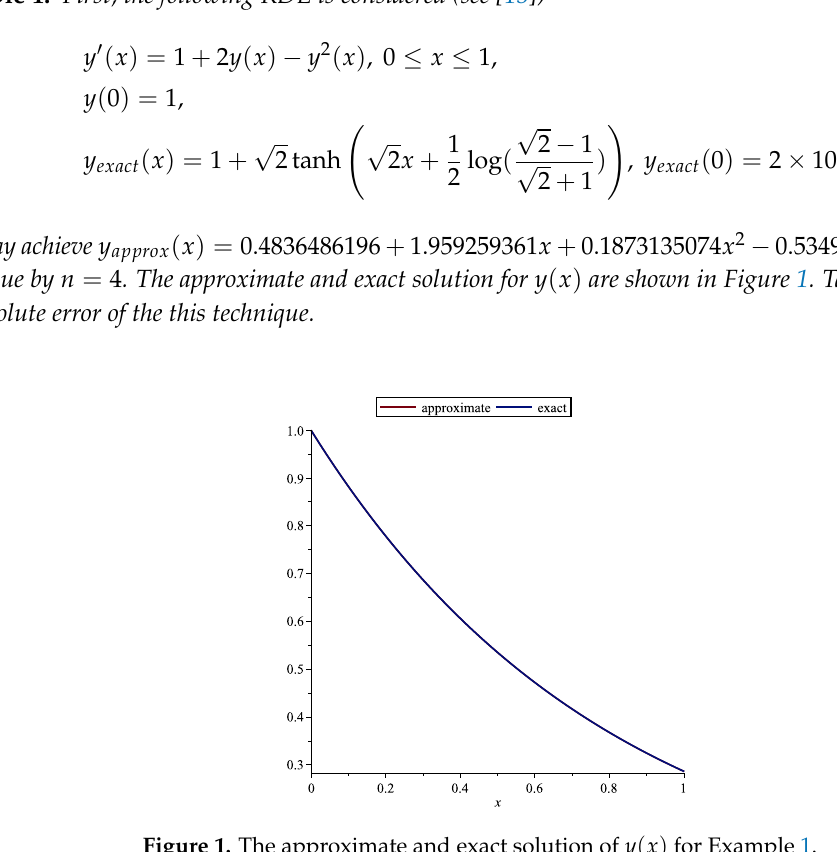
Figure 1. The approximate and exact solution of y ( x ) for Example